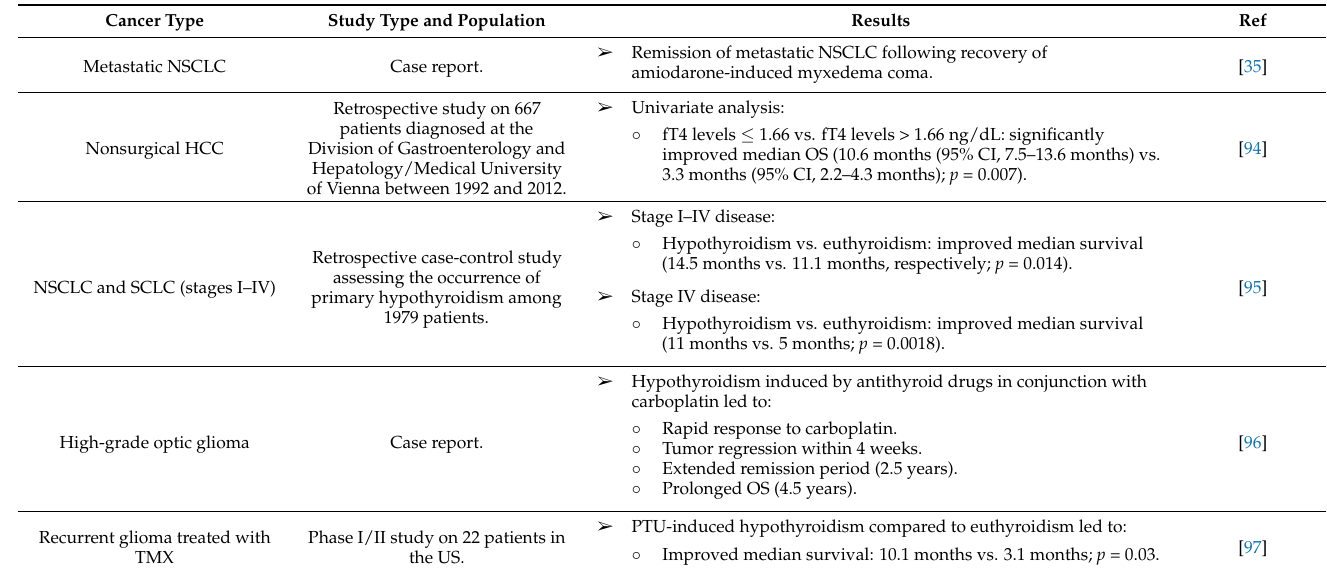
Table 2. Clinical data indicating an association between hypothyroxinemia or hypothyroidism and favorable cancer